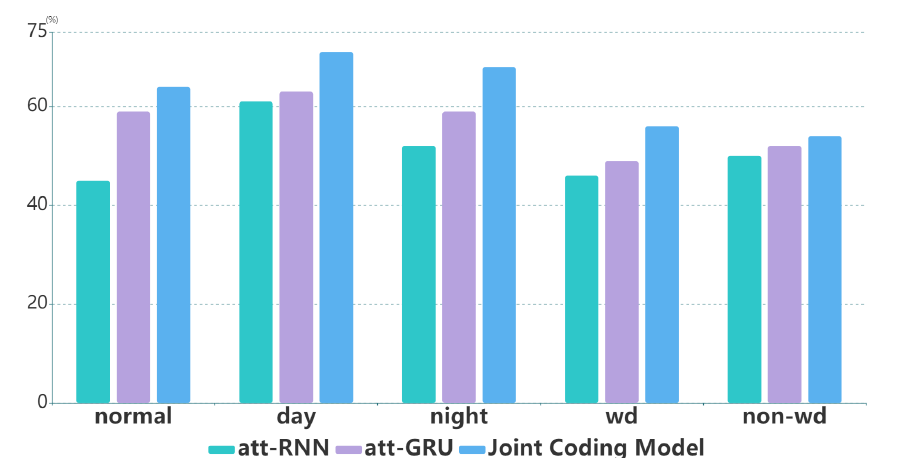
Figure 7. Recall@20 of different groups in experiment 2.